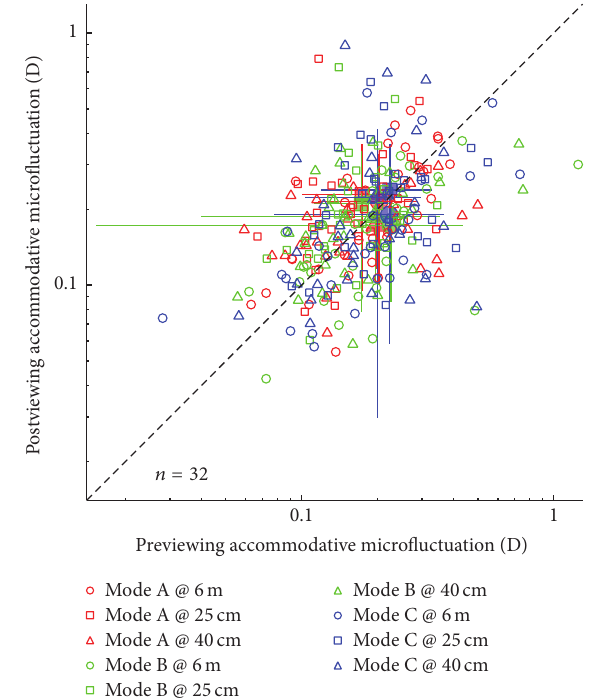
Figure 4: The effect of a 90-minute 3D viewing session on accommodative microfluctuation. The postviewing accommodative microfluctuations of individuals are plotted as open points as a function of their previewing accommodative microfluctuation measurements for the three illumination modes, which were measured at distances of 25 cm, 40 cm, and 6 m. The average values of the accommodative responses are plotted as solid points (the mean ± SD). The dashed line is the identity line ( 𝑋 = 𝑌